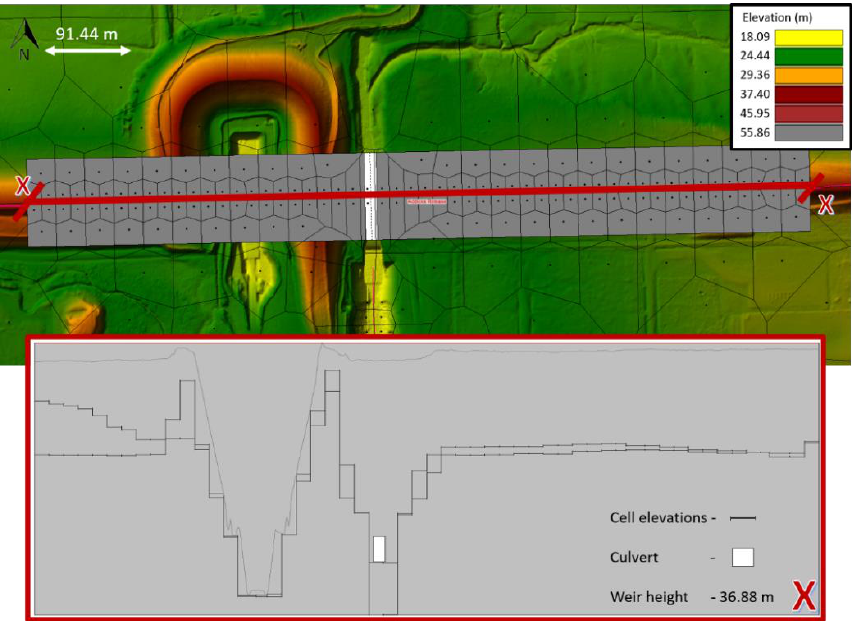
Figure 3. Plan and cross-sectional view of modeled outlet structure for Addicks Reservoir.